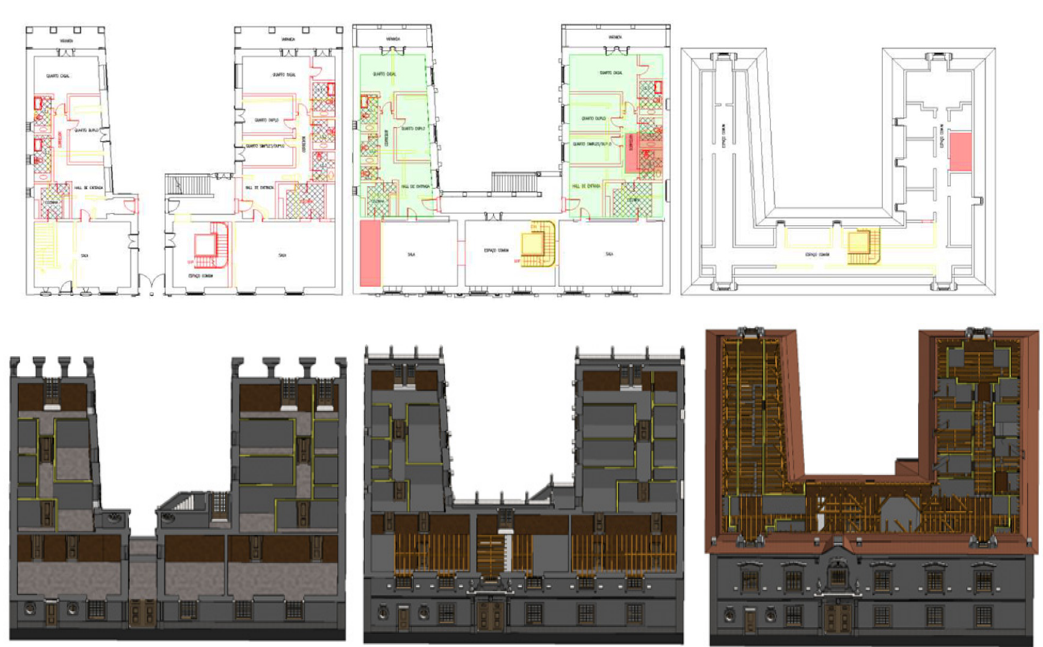
Figure 32. The BIM model of the proposed conversion of the